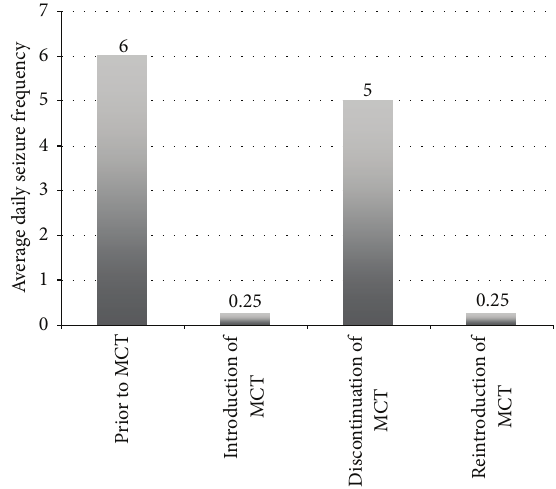
Figure 1: Demonstration marked reduction of daily seizure fre- quency after initiation of MCT oil supplementation. There is a transient rebound of seizures during a brief period of MCT